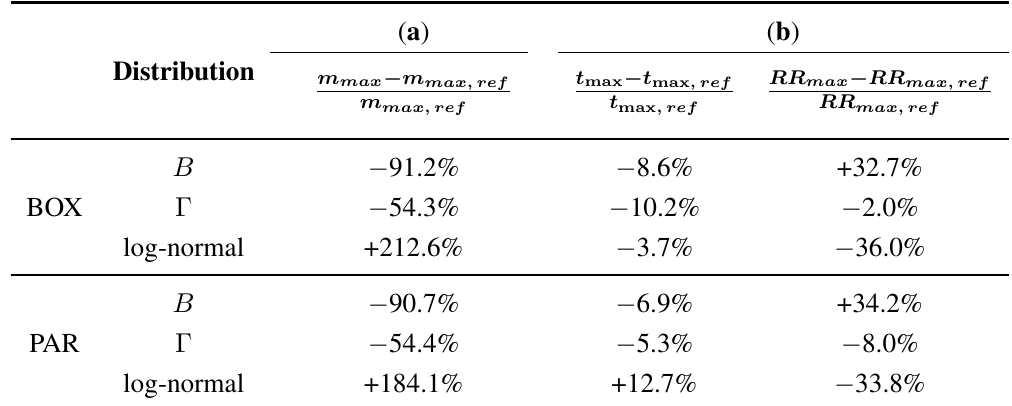
Table 4. ( a ) Maximum mean mass: the relative difference to the maximum reference mean mass; ( b ) the rain rate maximum at z = 5 . 75 km: delay in time compared to the time of the maximum in the reference solution ( left ) and the relative difference in value to the maximum of the reference rain rate ( right